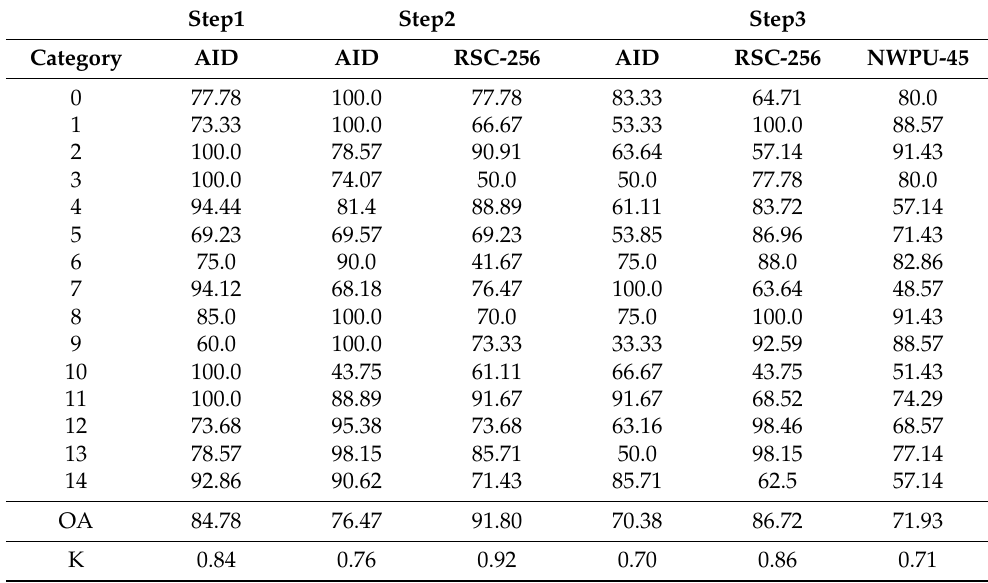
Table 4. Classification accuracy of partially scenes during three-step continual learning tasks.